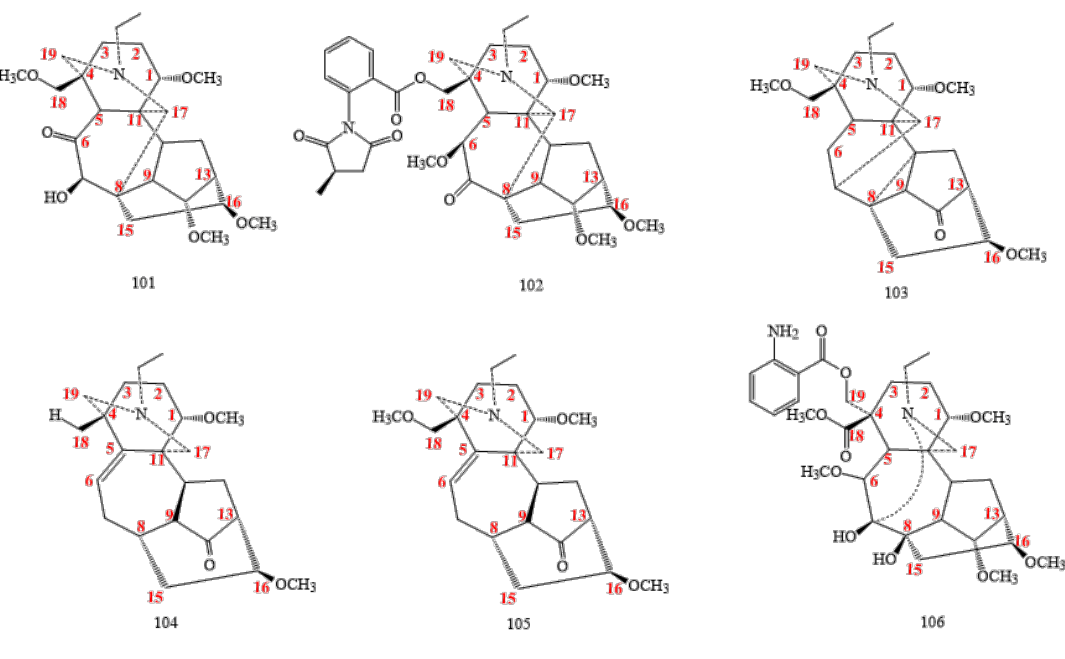
Figure 10. C 19 -glycosides DAs.